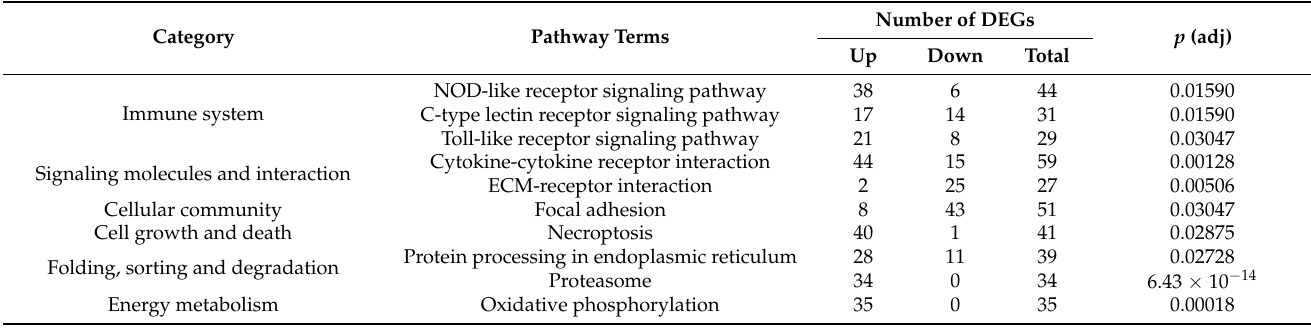
Table 2. KEGG enrichment analysis of DEGs in skin at 4 days post IHNV infection.